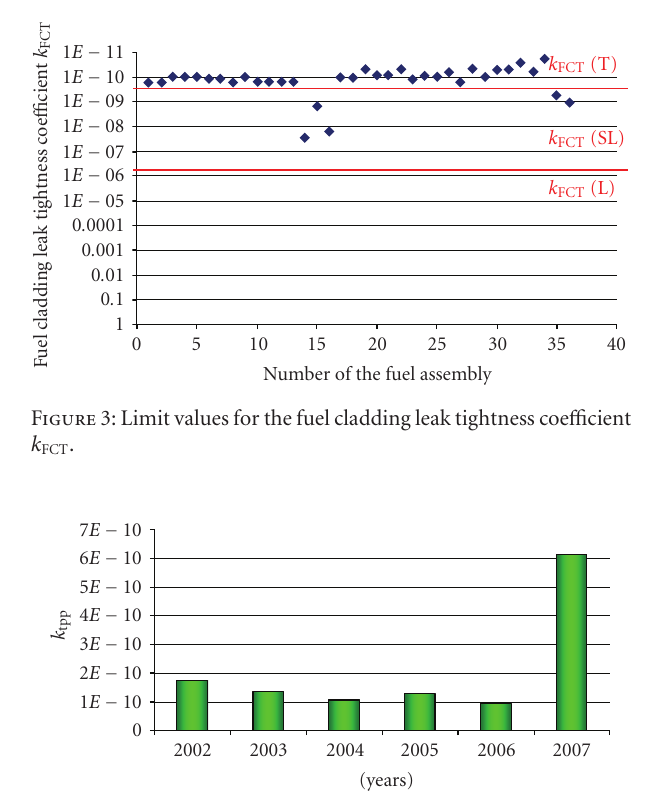
Figure 4: Values of k FCT for reference FA number 1.